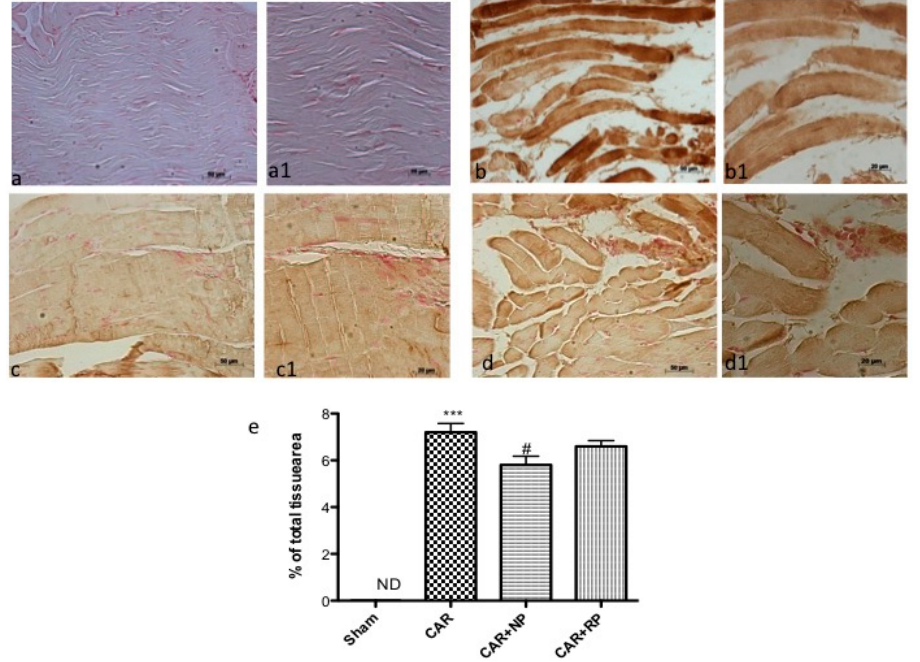
Figure 7. Peroxynitrite production following intraplantar injection of CAR in rat hind paw. Immunohistochemistry for nitrotyrosine showed positive staining in paw tissue sections from CAR-injected rats ( b ). The intensity of nitrotyrosine staining was significantly reduced in the paw from NP-treated rats ( c ); compared to RP-treated rats ( d ). ( a1 – d1 ) low magnification of the respective panels. The figures are representative of at least three independent experiments. *** p < 0.001 vs. Sham; # p < 0.05 vs. CAR.